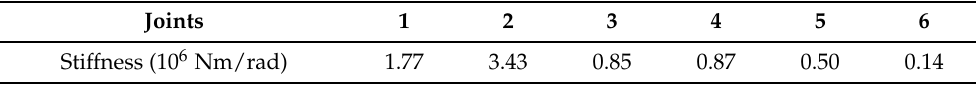
Table 2. The joint stiffness of the robot identification results.